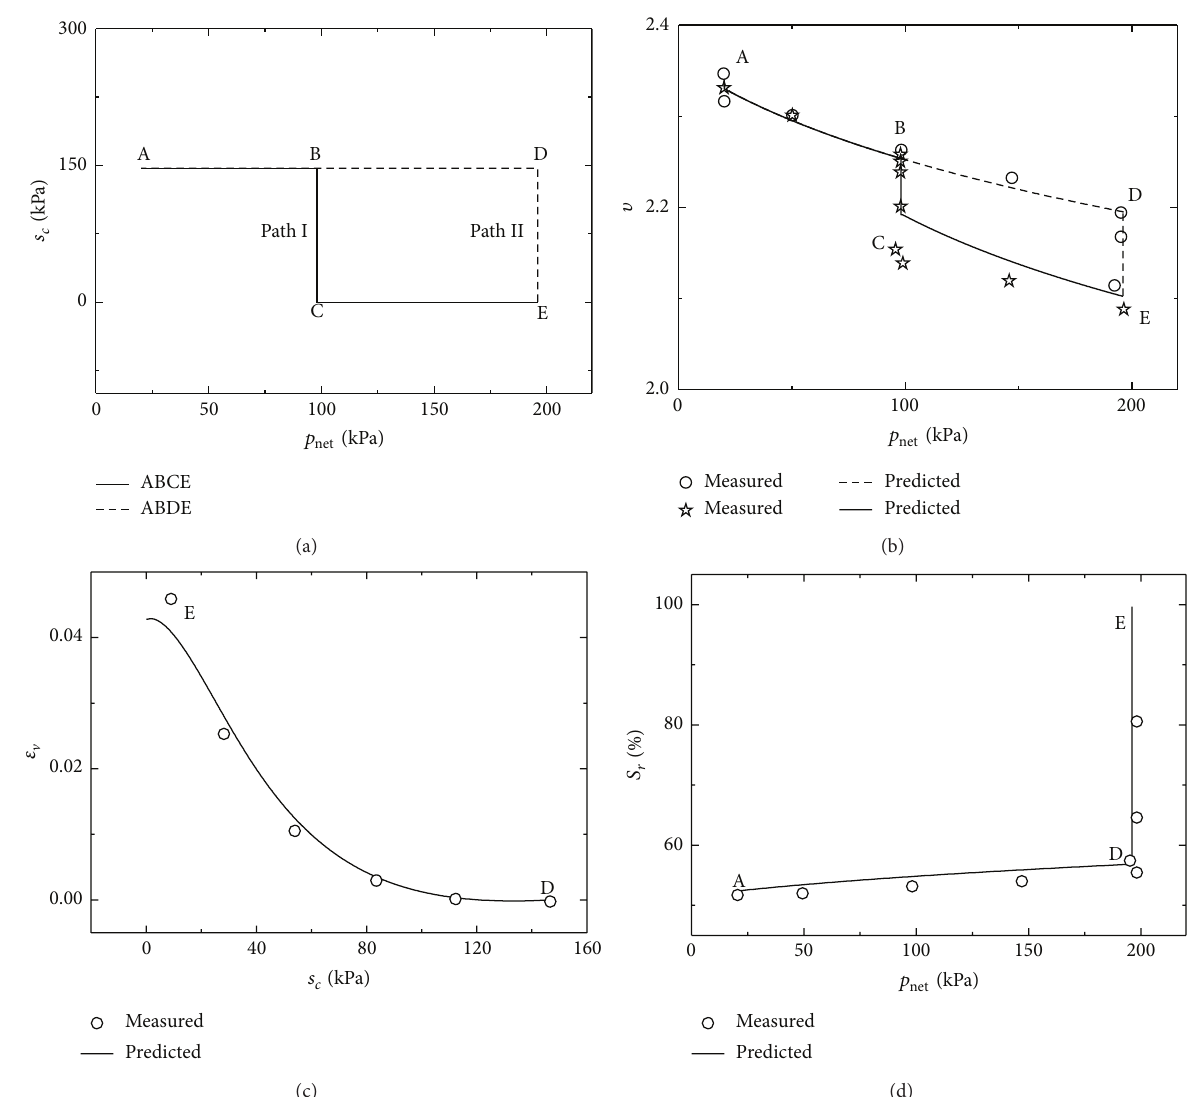
Figure 7: Simulated and measured results of wetting-collapse experiments on Pearl clay: (a) stress paths adopted; (b) relation between 𝑝 and 𝜐 ; (c) variation of total volumetric strain with matric suction during the wetting process D-E; (d) variation of the degree of saturation with net pressure for Path A-B-D-E. (data after Sun et al. (2007)